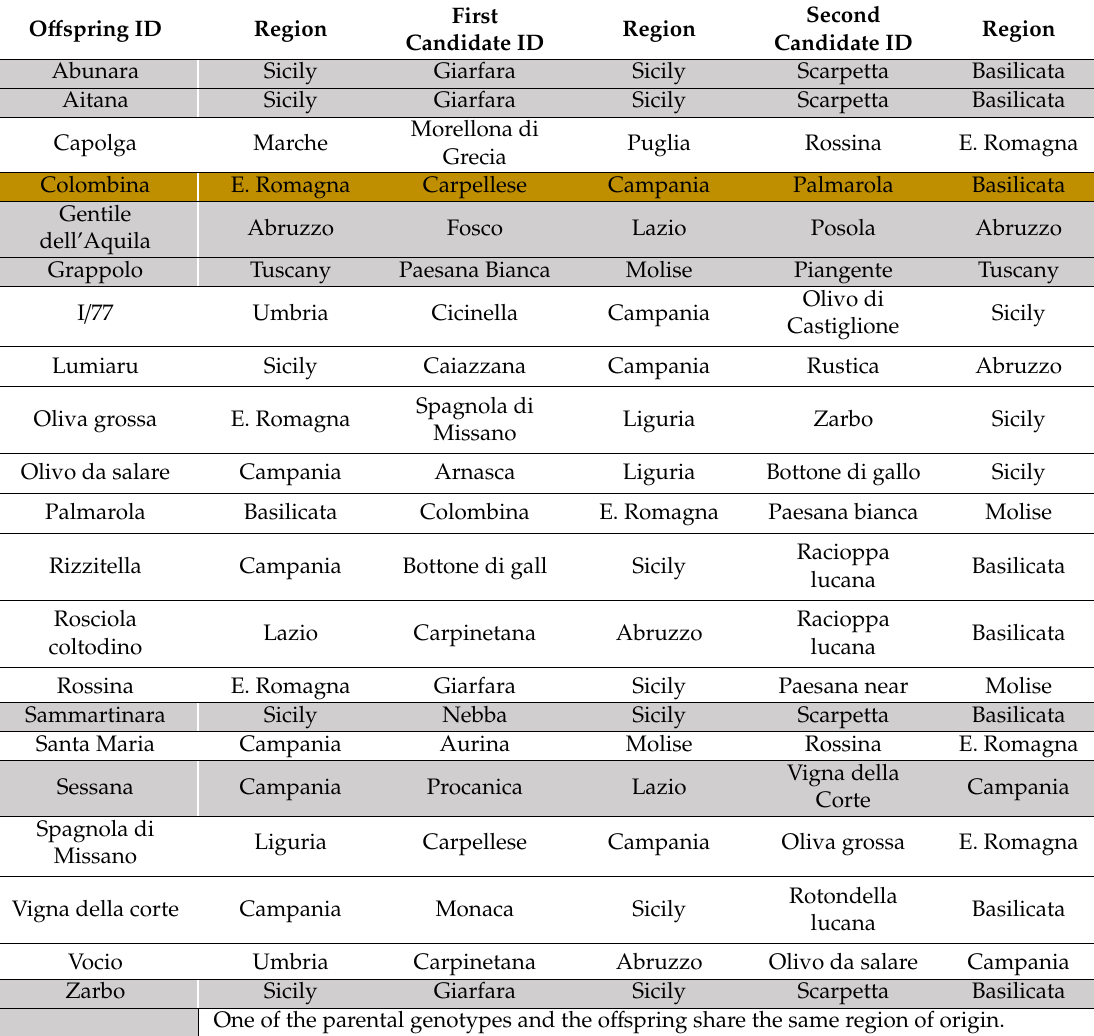
Table 5. Parentage analysis results. The table shows the olive cultivars identified as putative parents of the o ff spring cultivars, and the corresponding regions of